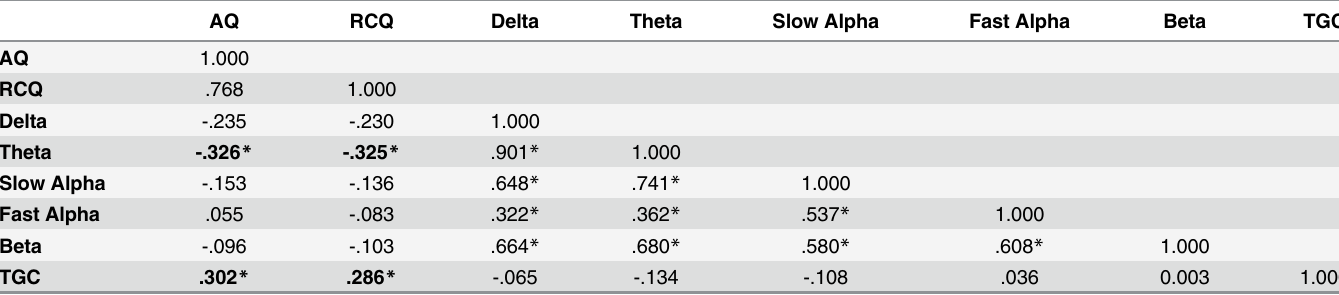
Table 3. The results of Pearson ’ s partial correlation analysis (adjusted for sex) of IVA CPT values and EEG